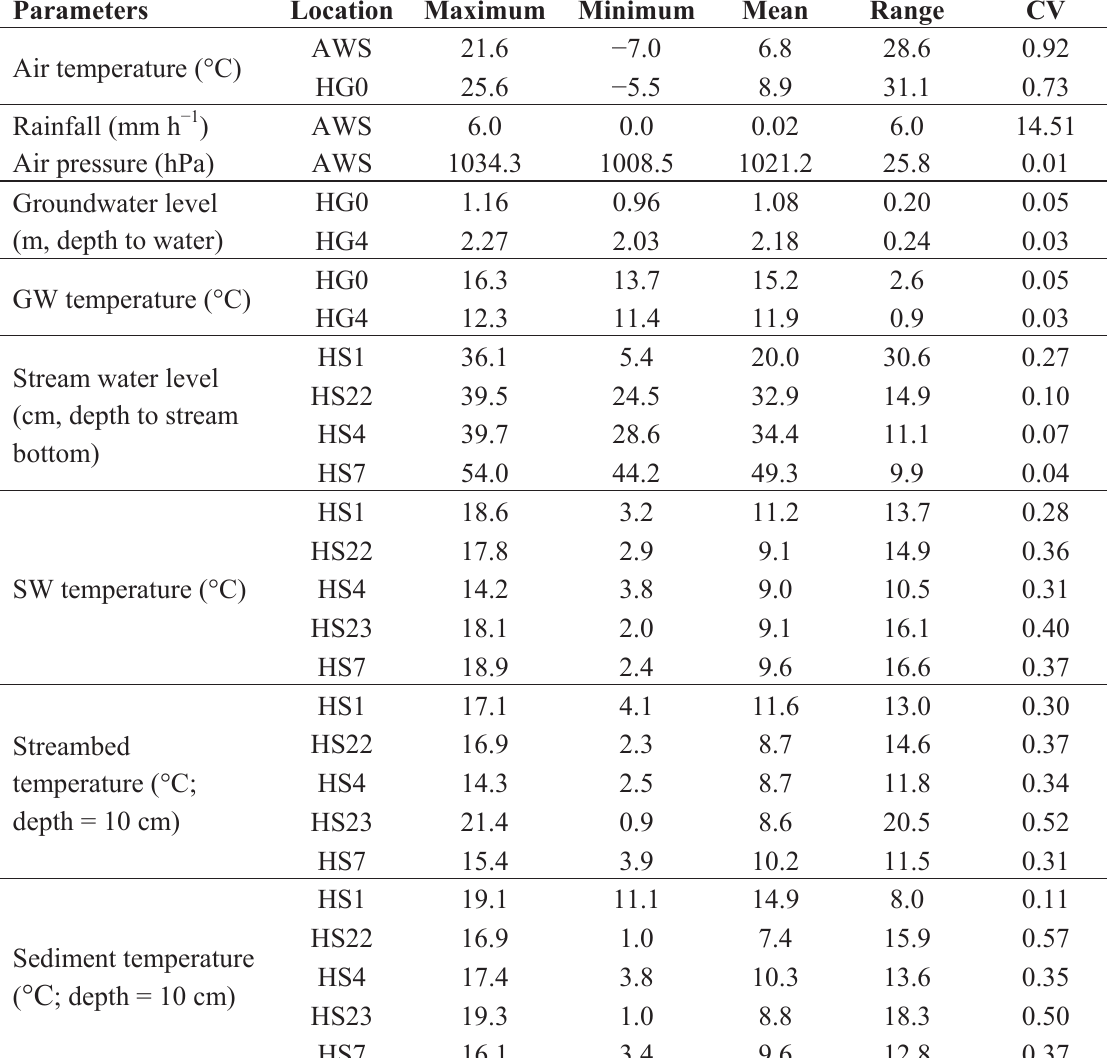
Table 3. Summary of monitoring data in the studied basin (data of 9 October–19 November were used for comparison consistency ( n = 1008) excepting stream level of 9 October–6 November ( n = 685) and a sediment temperature of 9–22 October at